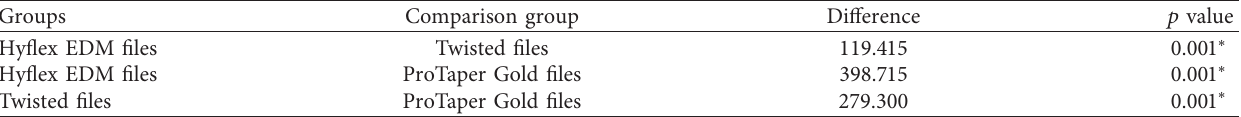
Table 2: Pairwise comparison of no. of cycles required for fracture using Tukey’s post hoc test.